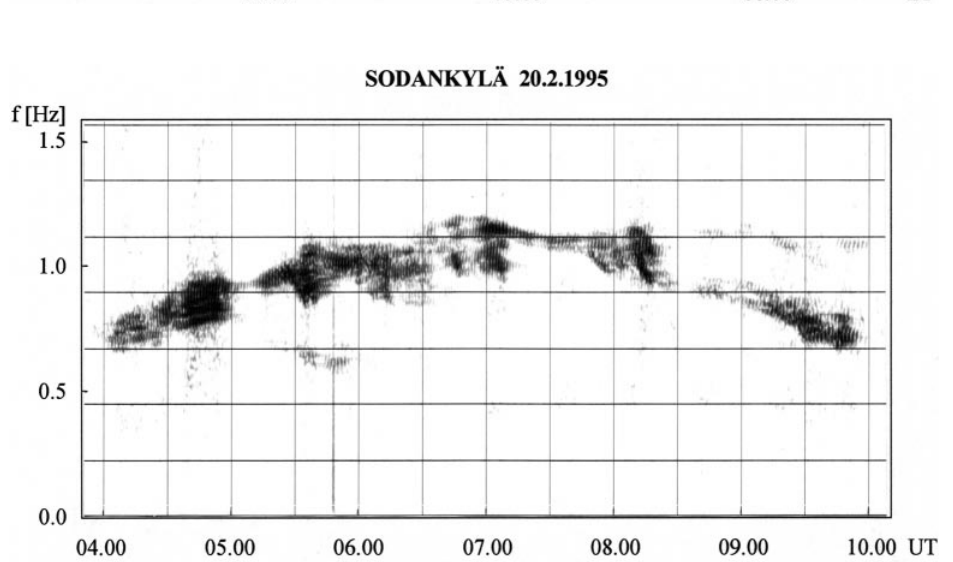
Fig. 2. The sonagram of Pc1 pulsations observed at Oulu on October 17, 1986, showing an increasing central frequency